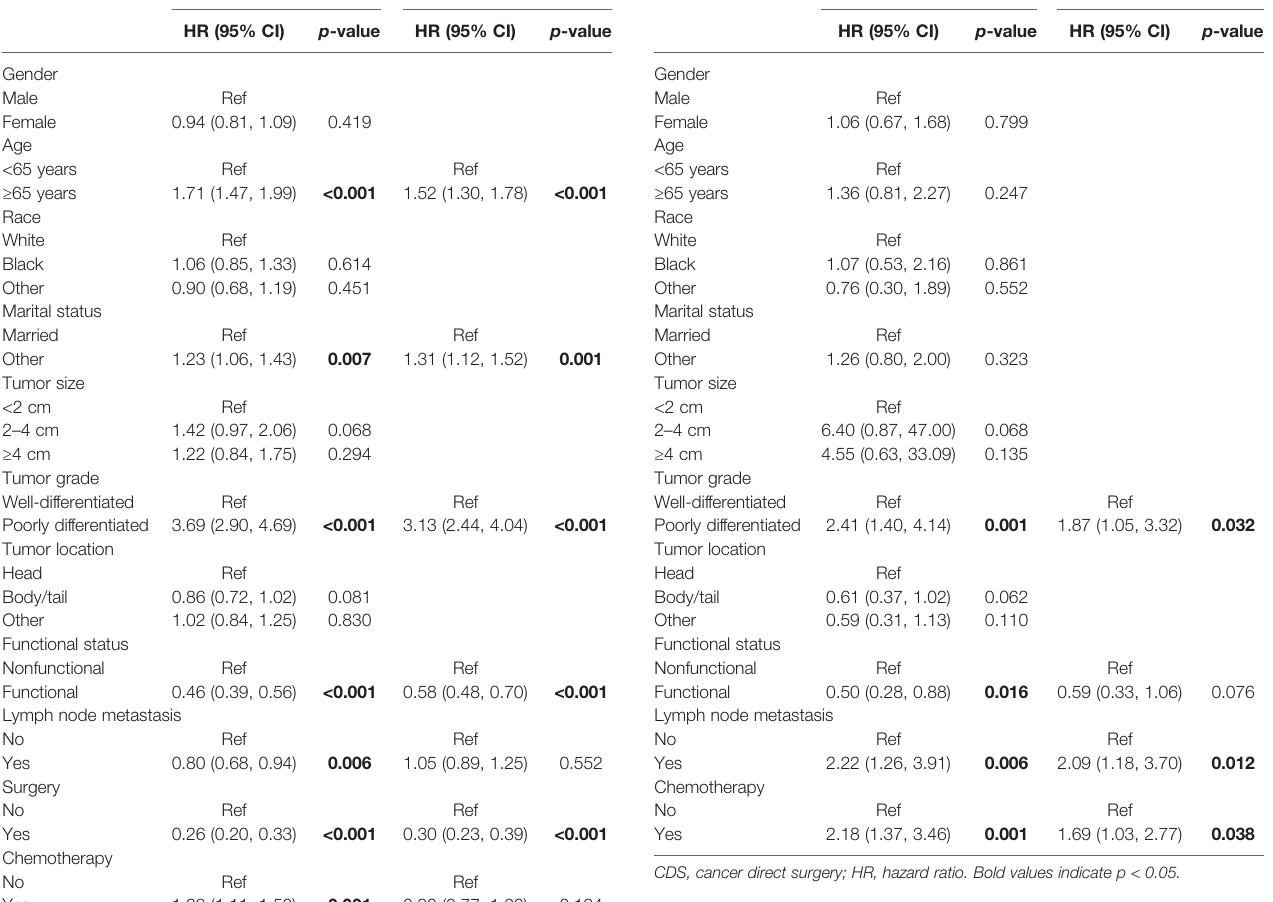
TABLE 2 | Association of clinicopathological factors with OS in oligometastatic liver metastasis in PNET patients. Variables